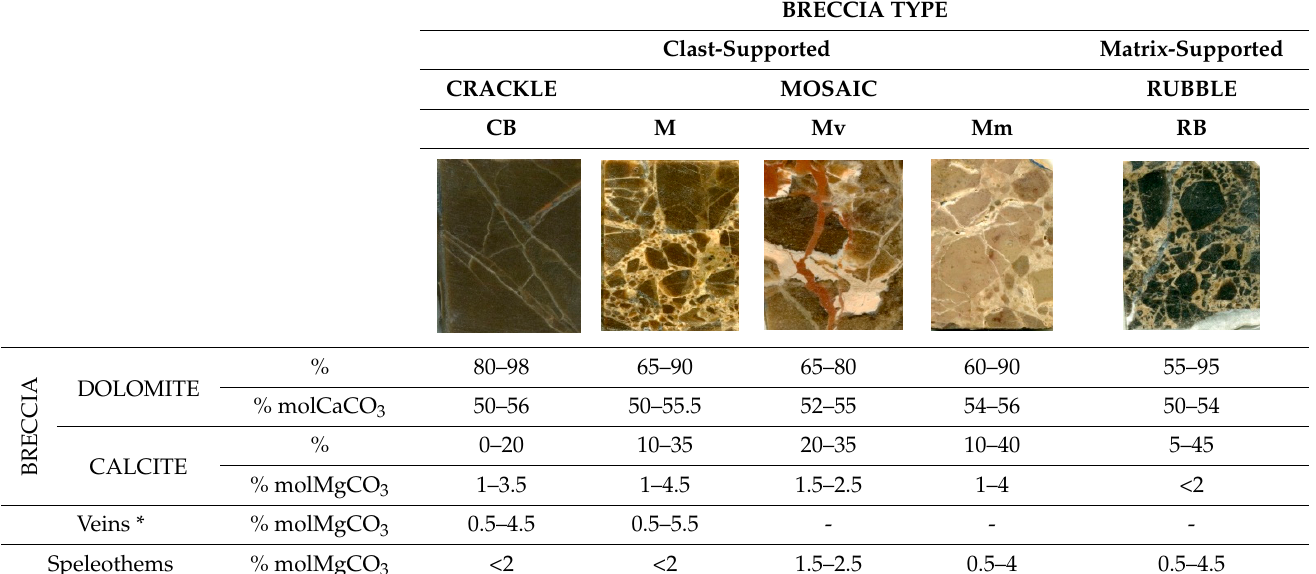
* Only veins > 5 mm